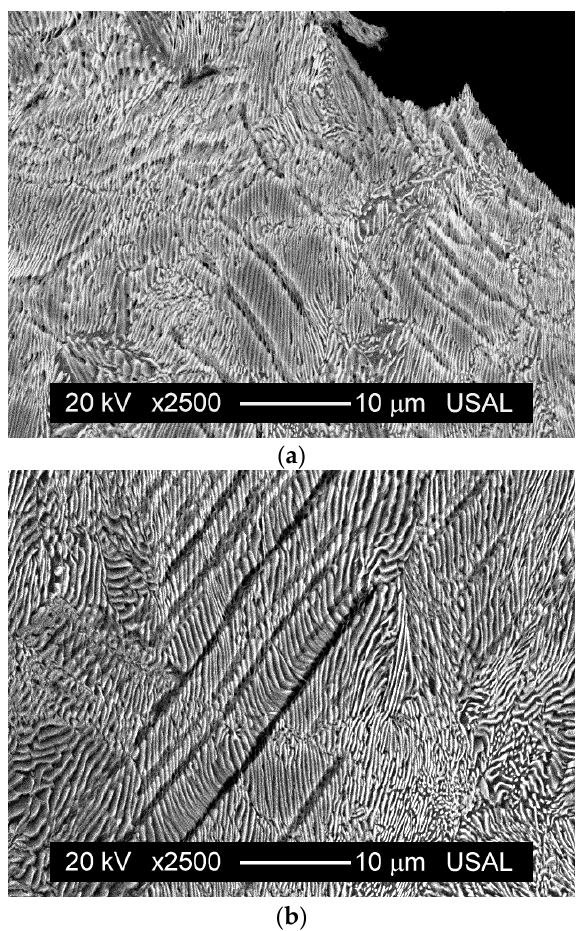
Figure 10. Micro-damage in steels cooled in a FCF: ( a ) in the close vicinity of the main crack; ( b ) below the previous area. In both micrographs, the vertical size represents the wire axis (direction of applying the load in the standard tensile test).